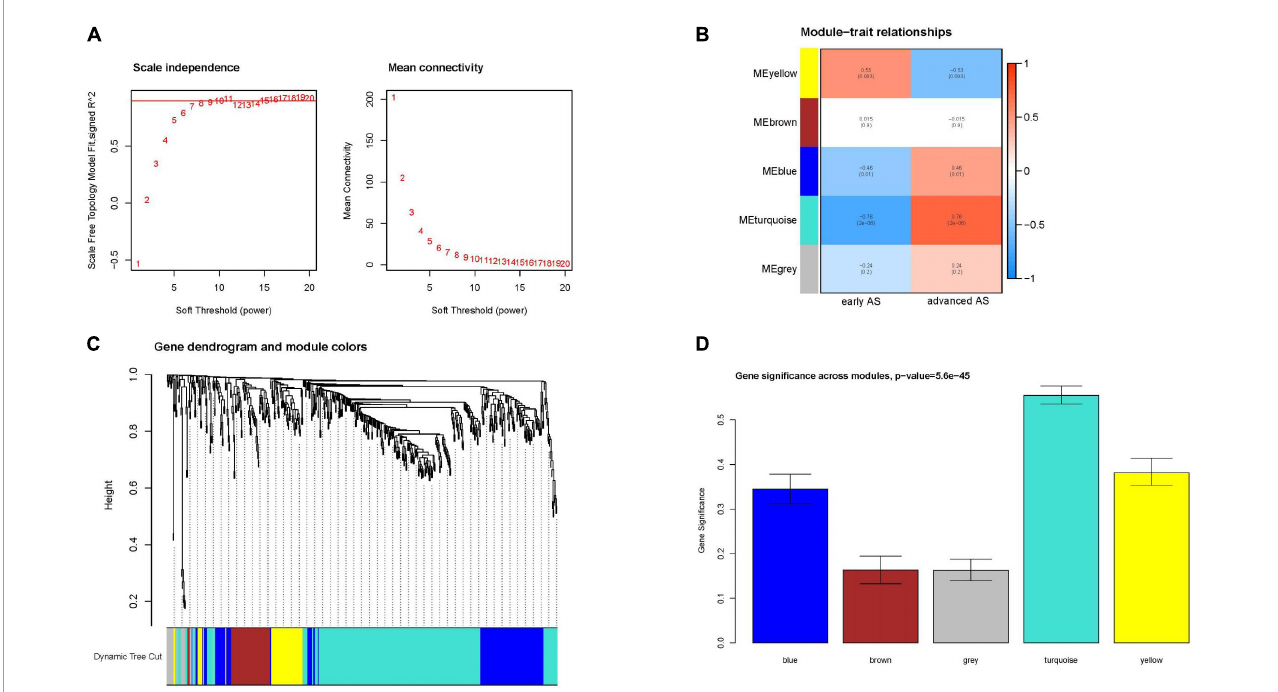
FIGURE3 Module gene screening. (A) Network topology analysis. (B) Module-trait relationships. (C) Gene clustering dendrogram. (D) Module gene importance histogram.